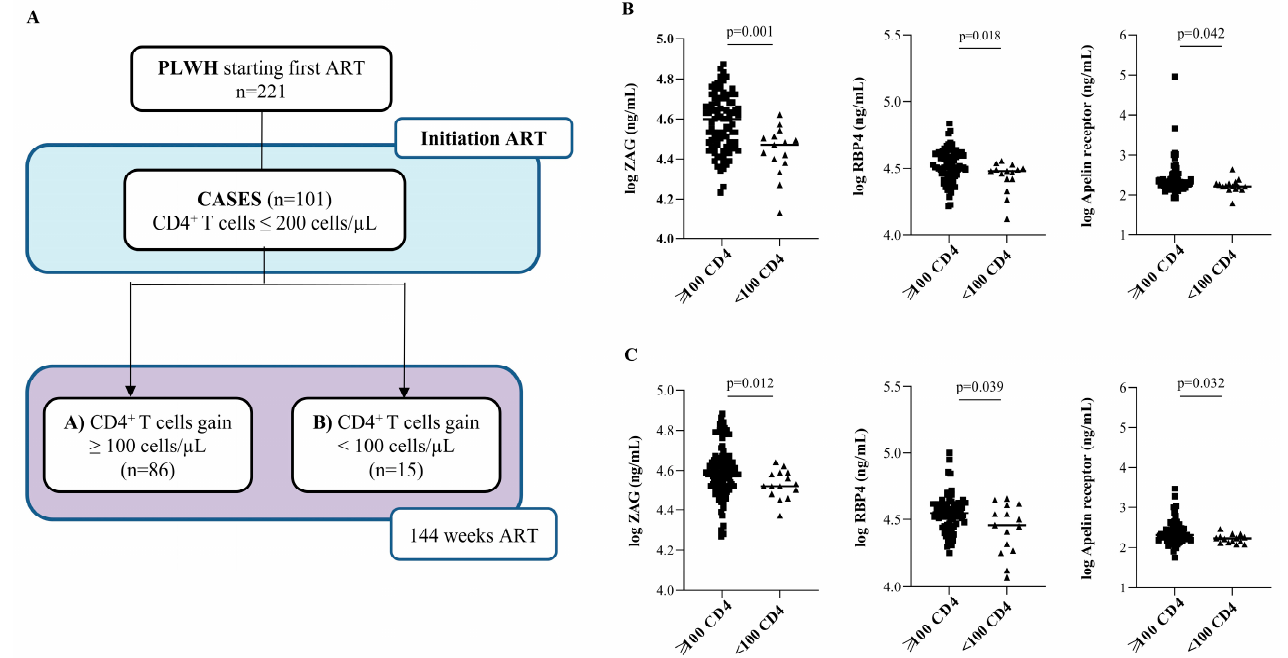
Figure 4. Validation cohort using CD4 + T-cell count gain as a marker of immune recovery. ( A ) Flow chart illustrating cases ( n = 101) categorized according to CD4 + T-cell count gain after 144 weeks of ART initiation instead of 250 cell/ µ L CD4 + T-cell count cut-off: A group for those who gained ≥ 100 cells/ µ L, and B group for those who gained < 100 cells/ µ L. ( B ) Circulating ZAG, RBP4, and APLNR concentrations at baseline ( B , C ) at 144 weeks of ART. p -value indicates significant differences among indicated groups by nonparametric Mann–Whitney test.